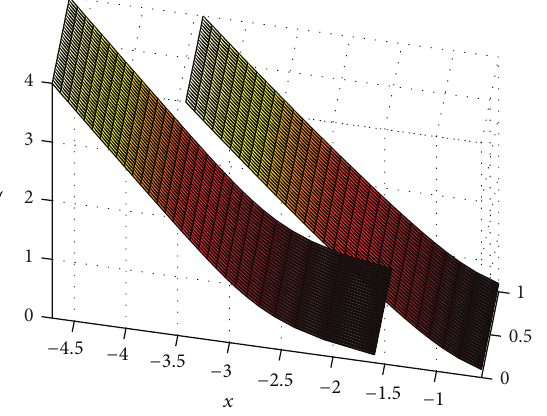
Figure 15: 𝛼 = 0.3 and 𝜆 = 2